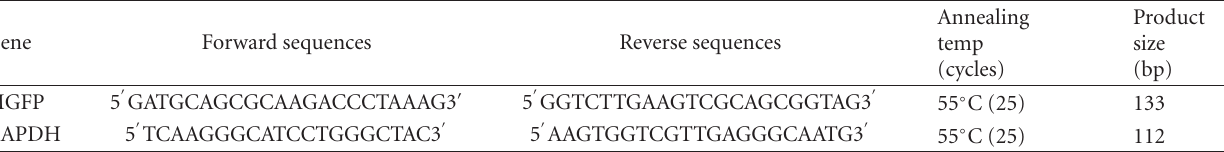
Table 1: Primer sequences used in PCR.